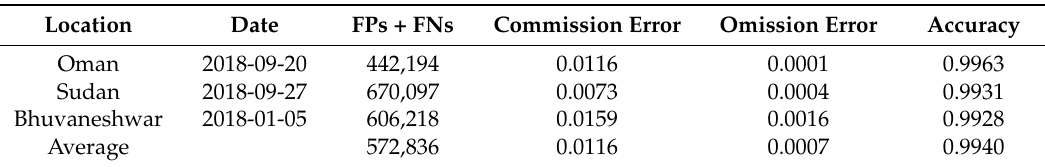
Table 7. Quantitative evaluation of the performance of the proposed method in the case of Sentinel-2 images.